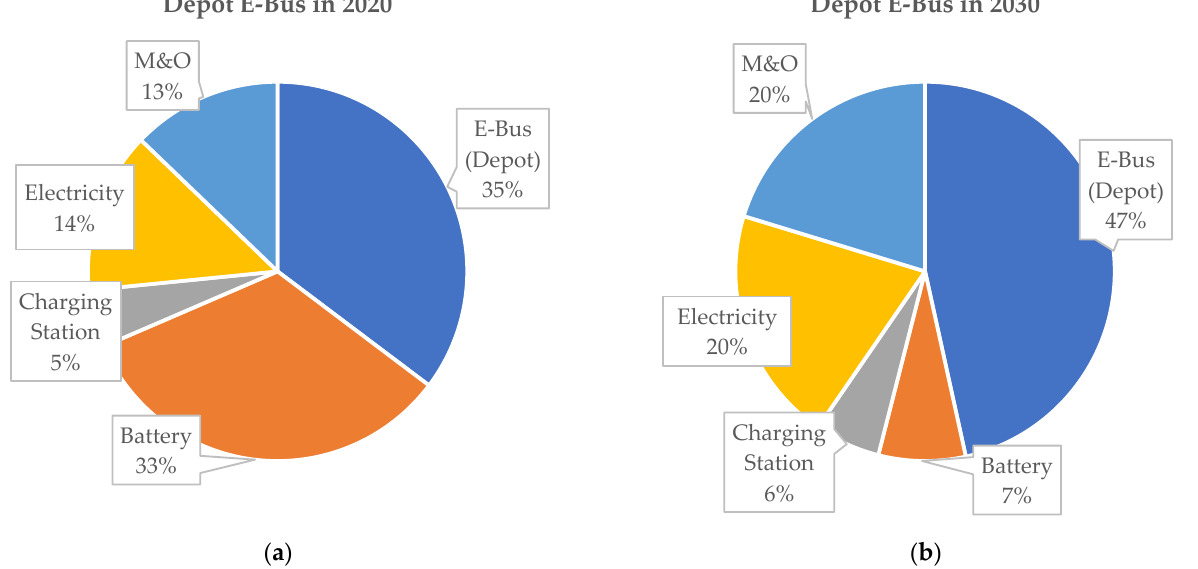
Figure 11. TCO estimations for battery electric bus with depot charging: ( a ) in 2020; ( b ) in 2030.